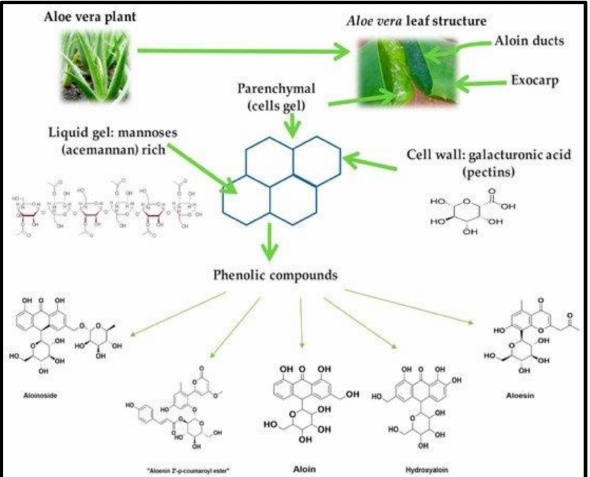
Figure 1. Aloe vera plant and chemical structure of its main components. Reproduced with permission from